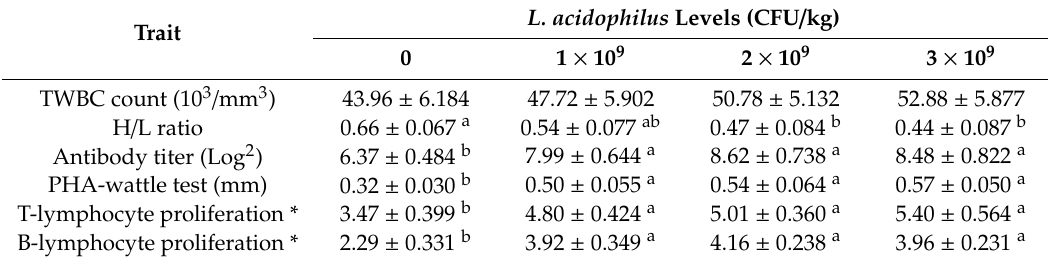
Table 3. E ff ect of dietary Lactobacillus acidophilus supplementation on immune response parameters of laying